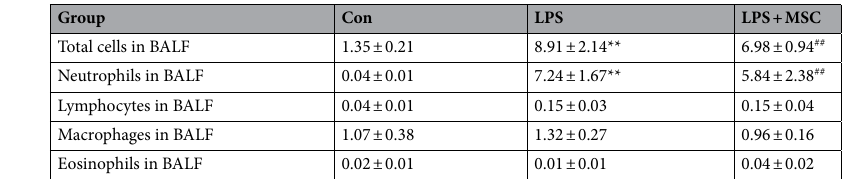
Table 1. Cell counts in the BALF (cells/mL) at 6 h after LPS treatment. Increases in the numbers of total cells and neutrophils in the BALF were detected after LPS injection, while BM-MSCs prevented the increase in the numbers of total cells and neutrophils in the BALF. Treatment with LPS and BM-MSCs did not alter the numbers of lymphocytes, macrophages, or eosinophils in the BALF. Values are expressed as the mean ± SD.